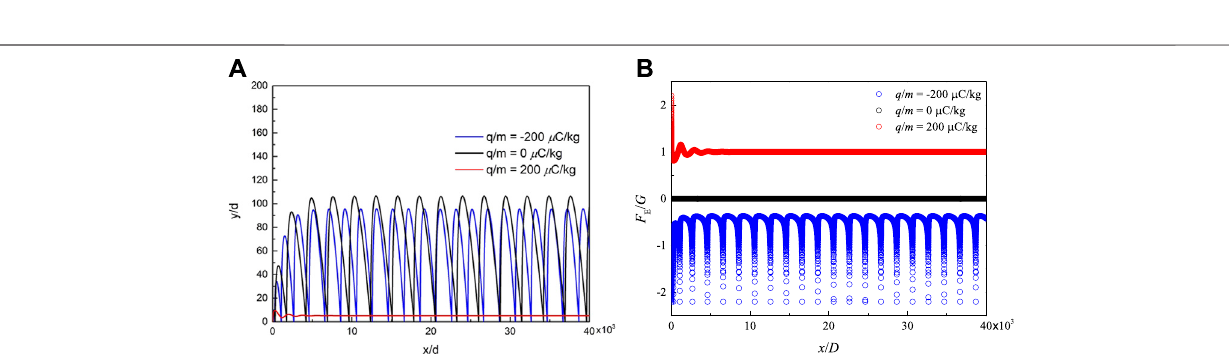
Frontiers in Earth Science |